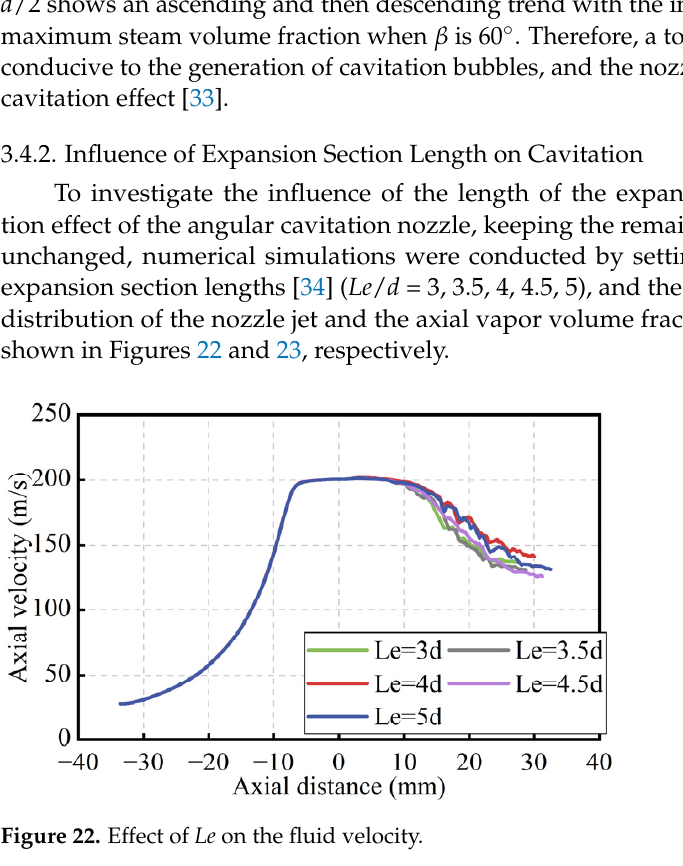
Figure 22. Effect of Le on the fluid velocity.